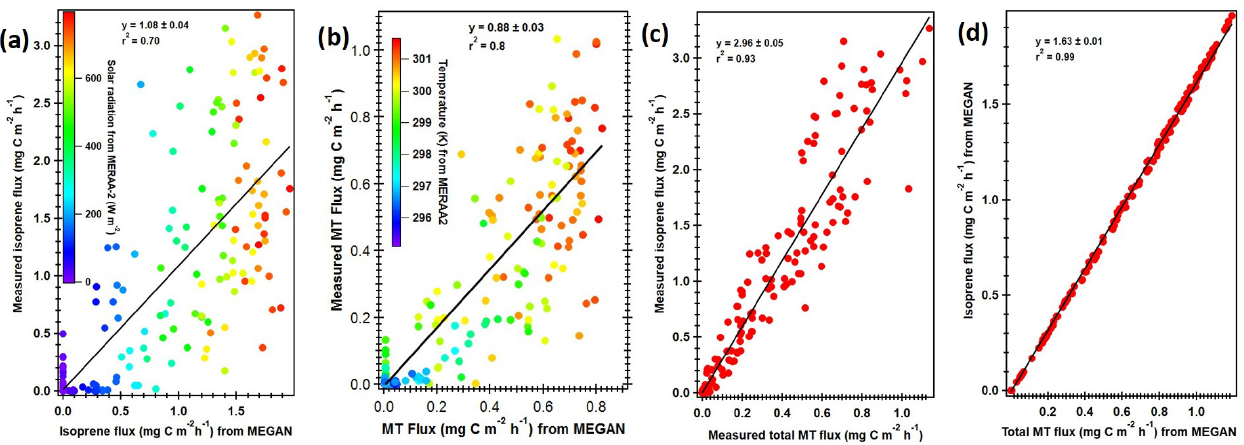
Figure 5. Scatterplots for measured and MEGAN2.1 estimated isoprene and total monoterpene fluxes and their